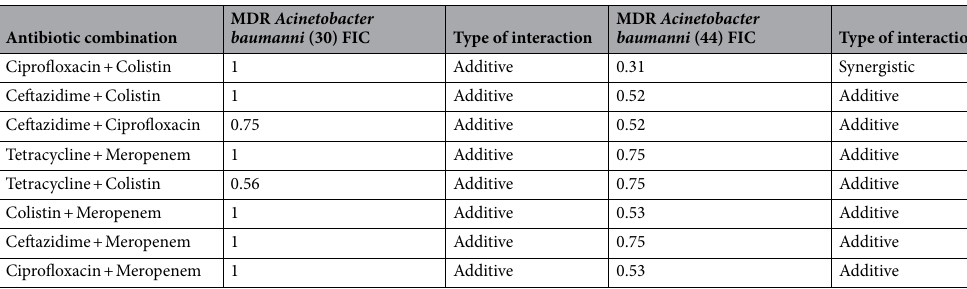
Table 6. Summary of antibiotic combination therapy results for the studied organisms.